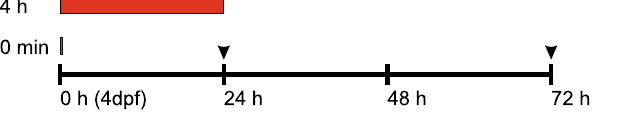
Figure 1. Reserpine treatment and experiment timeline. The reserpine treatment was started at 4 dpf and lasted either for 20 min (short treatment) or 24 h (long treatment). The treatment period is indicated by the red bar in the graph. Experiments were done at 24 h and 72 h after the start of the treatment, as indicated by the time points in the figure